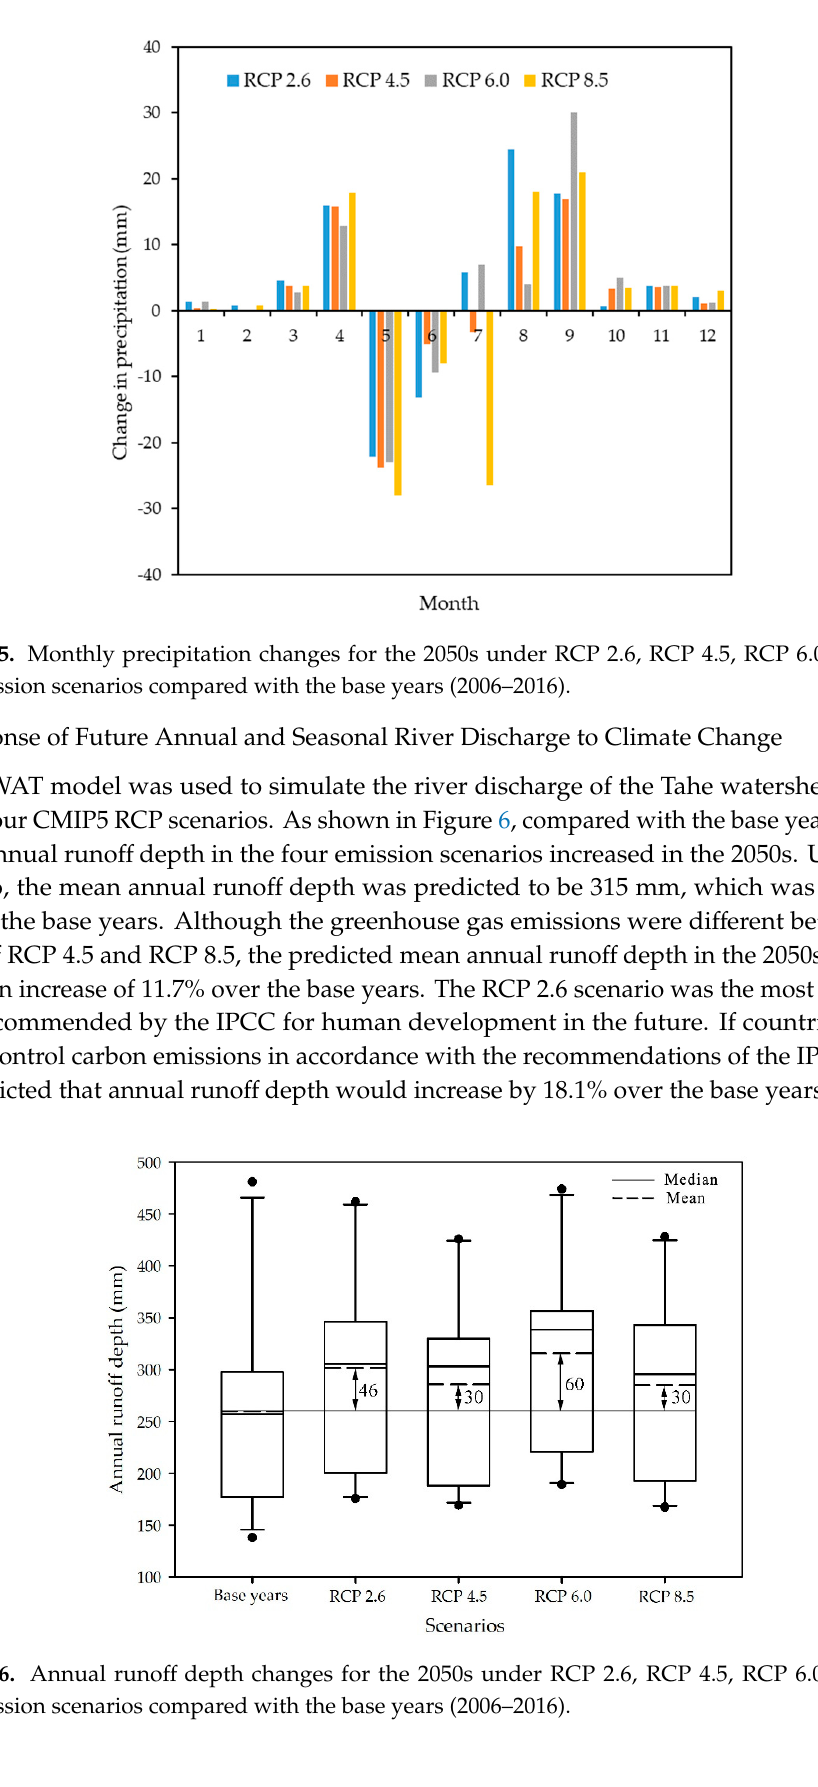
Figure 7. Monthly runoff depth changes for the 2050s under RCP 2.6, RCP 4.5, RCP 6.0 and RCP 8.5 emission scenarios compared with the base years (2006–2016). 5. Discussion 5.1. Discussion At present, statistical approaches and hydrological models are two common methods for quantifying the relative contributions of climate and forest change on hydrology in large watersheds [37]. In this study, the SWAT hydrological model was used to quantitatively estimate the impact of forest change on river discharge in the Tahe watershed. Our results indicated that deforestation increased annual runoff depth while tree species composition shift and reforestation decreased annual runoff depth in the Tahe watershed, which were similar to the results by statistical approaches in the previous study [12]. The results were also consistent with previous studies on the impacts of